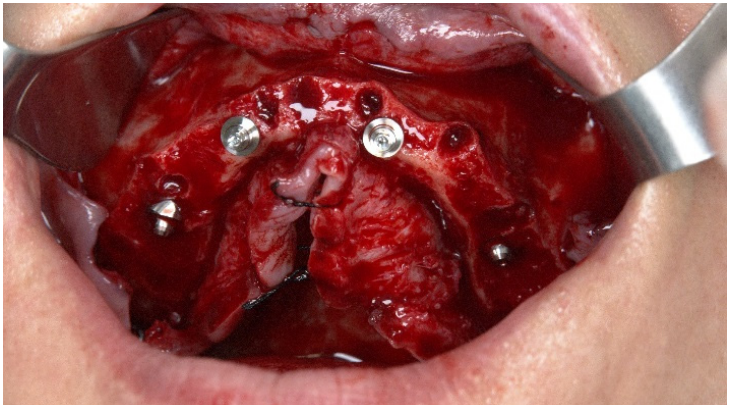
Figure 15. Perioperative photograph after connection of the abutments.